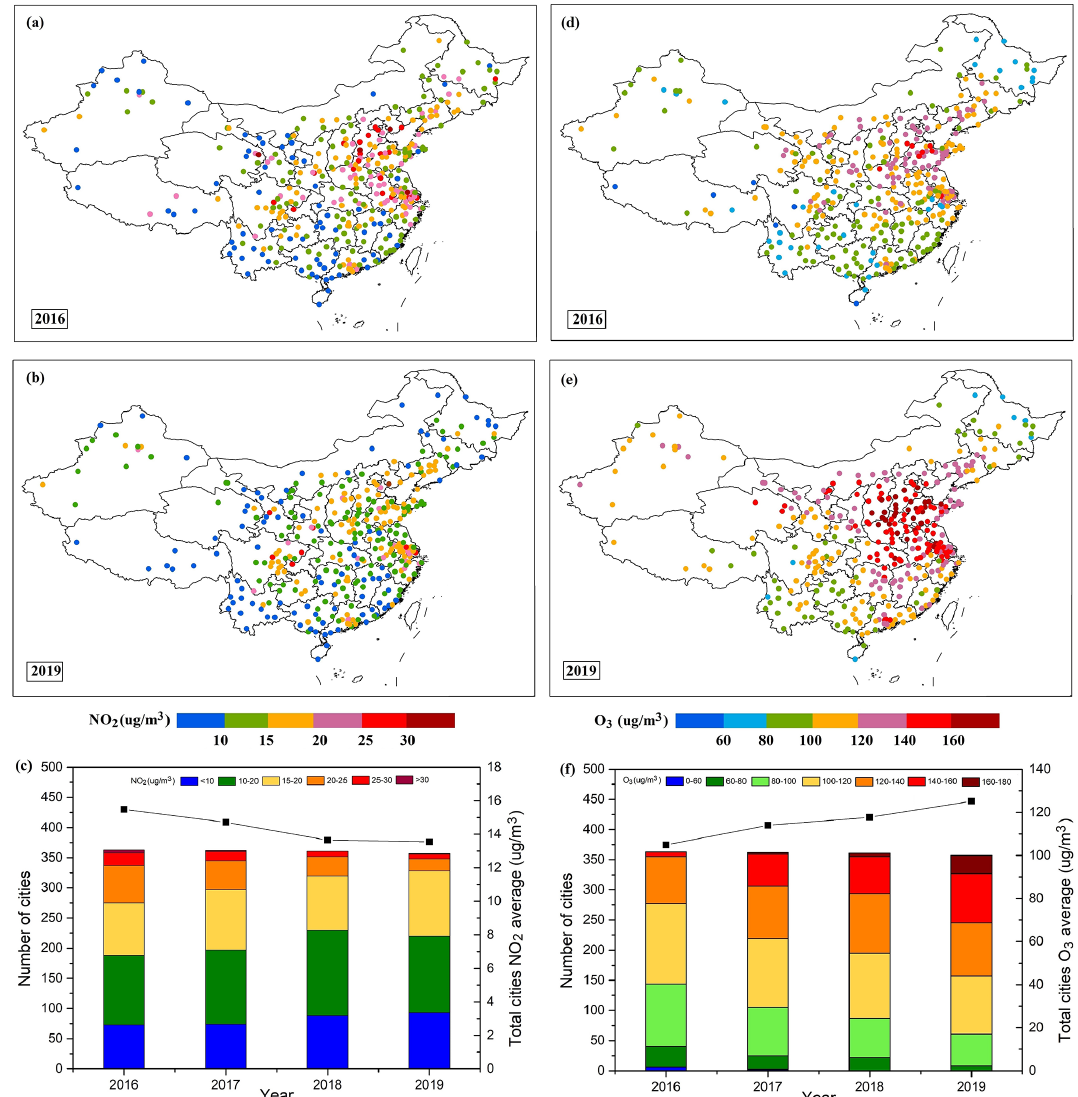
Figure 4. (a) Mean ground-based NO 2 concentration at each city in the summer of 2016. (b) Same as (a) but for 2019. (c) The bars indicate the number of cities (left axis) in a certain NO 2 range in summer from 2016 to 2019. The black line indicates the average NO 2 concentration (right axis) of all cities. (d) Mean ground-based O 3 concentration at each city in summer of 2016. (e) Same as (d) but for 2019. (f) Same as (c) but for O 3 . Note that daily in situ NO 2 and O 3 data are the average of 13:00–14:00LT of the sites in each